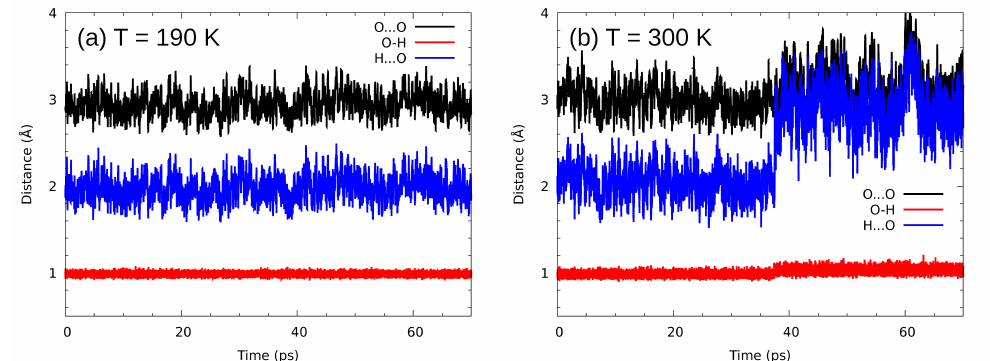
Figure 8. Time evolution of metric parameters related to a selected hydrogen bridge. Results of CPMD simulations in two temperatures: ( a ) 190 K and ( b ) 300